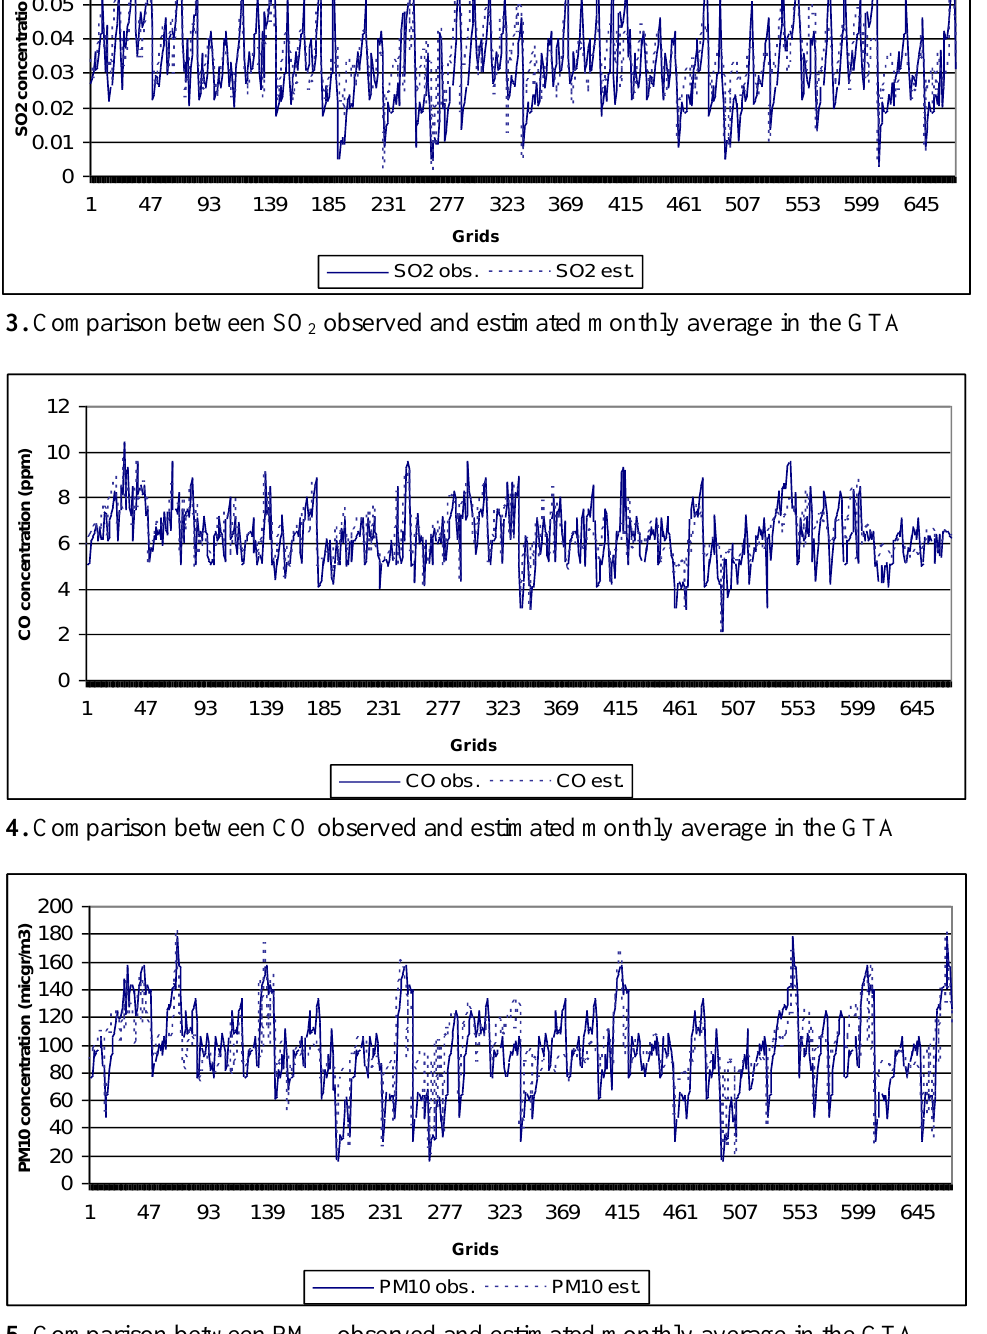
observed and estimated monthly average in the GTA 10